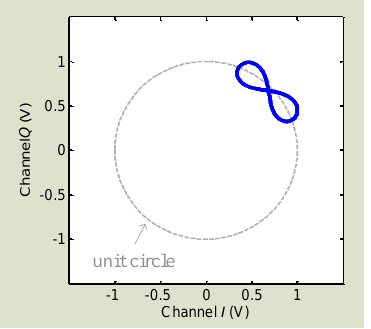
Figure 8. Signal distortion happens due to AC coupling. The trajectory is not an ideal arch but shows a ribbon-like shape in the I / Q plane.